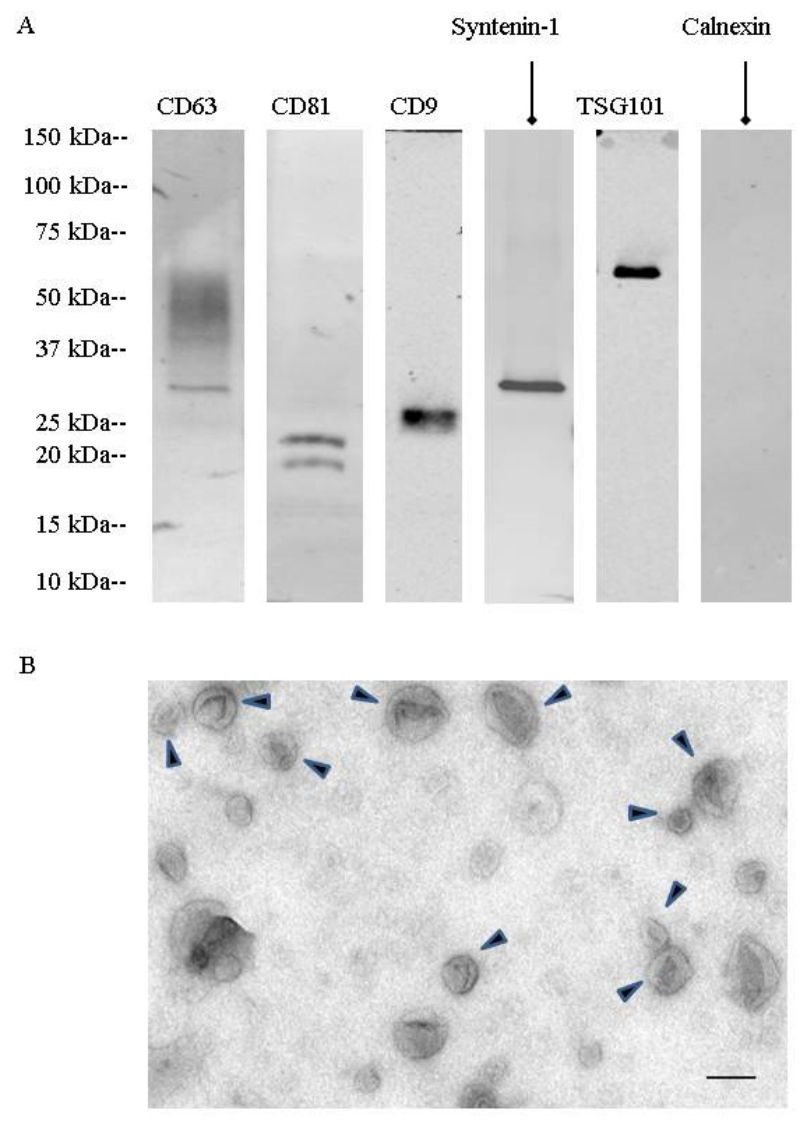
Figure 1. Characterization of urinary exosomes isolated by differential centrifugation. ( A ) Western blotting analysis of 200-kg sample protein contents isolated from urine collected from cystic fibrosis (CF) patients and age-matched control individuals showed the presence of the exosomal markers CD63, CD81, CD9, TSG101, syntenin-1, but not the endoplasmic reticulum-specific marker Calnexin. ( B ) Representative wide field EM image of the contents in the 200-kg pellet showing extracellular vesicles of typical exosome size and shape (scale bar = 200 nm). Arrows: